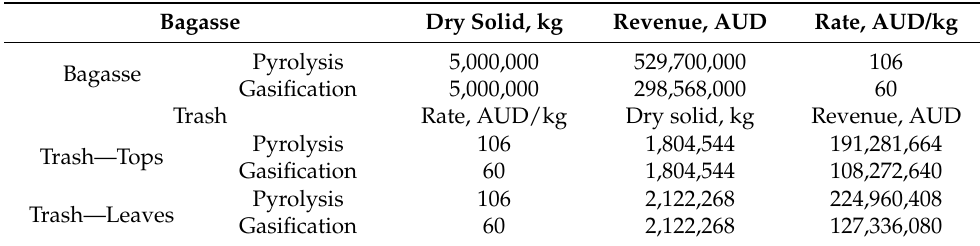
Table 32. The potential revenue from pyrolysis and gasification of cane trash based on AUD/kg generated from bagasse/cane